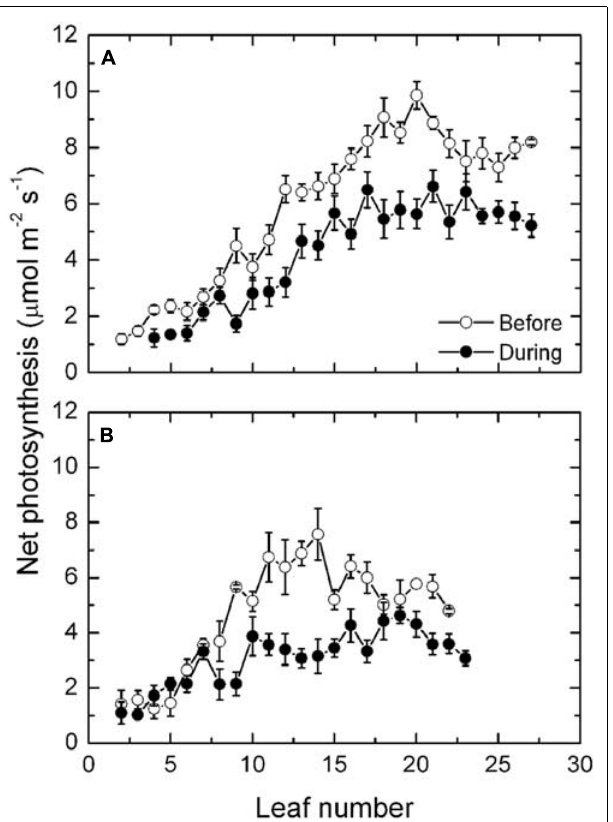
FIGURE 4 | (A,B) Transpiration rates (mean ± SE, N = 12) at different leaf positions along the shoot of Semillon vines either prior to (7th January, 104 DAB) or on one day (4th February, 132 DAB) during the 14-day period of high temperatures as indicated.The vines were grown in an irrigated vineyard (A) without protection and (B) with protection provided by shade cover over the